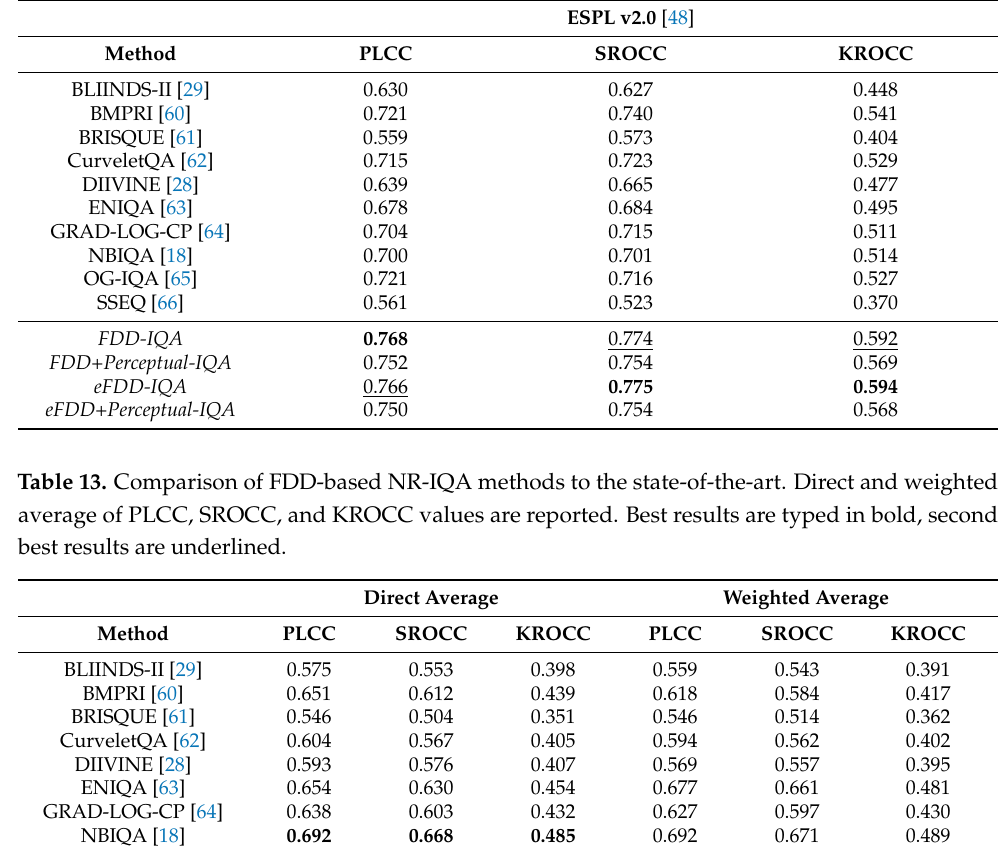
Table 12. Comparison of FDD-based NR-IQA methods to the state-of-the-art on synthetic images (ESPL v2.0 [48]). Median PLCC, SROCC, and KROCC values were measured over 1000 random train–test splits. Best results are typed in bold, and second best results are underlined.